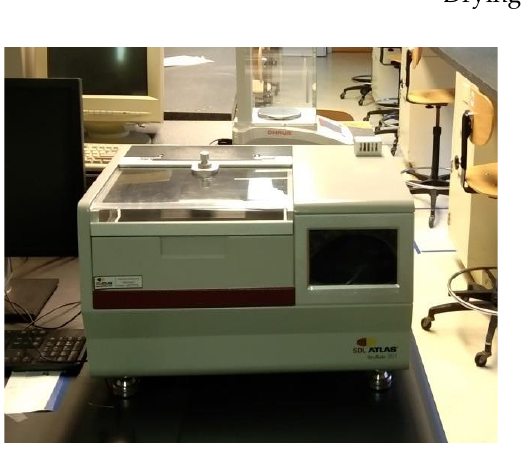
Figure 2. Fabric Drying Performance Evaluation Tester, SDL Atlas, Rock Hill, SC as per AATCC 201 method.